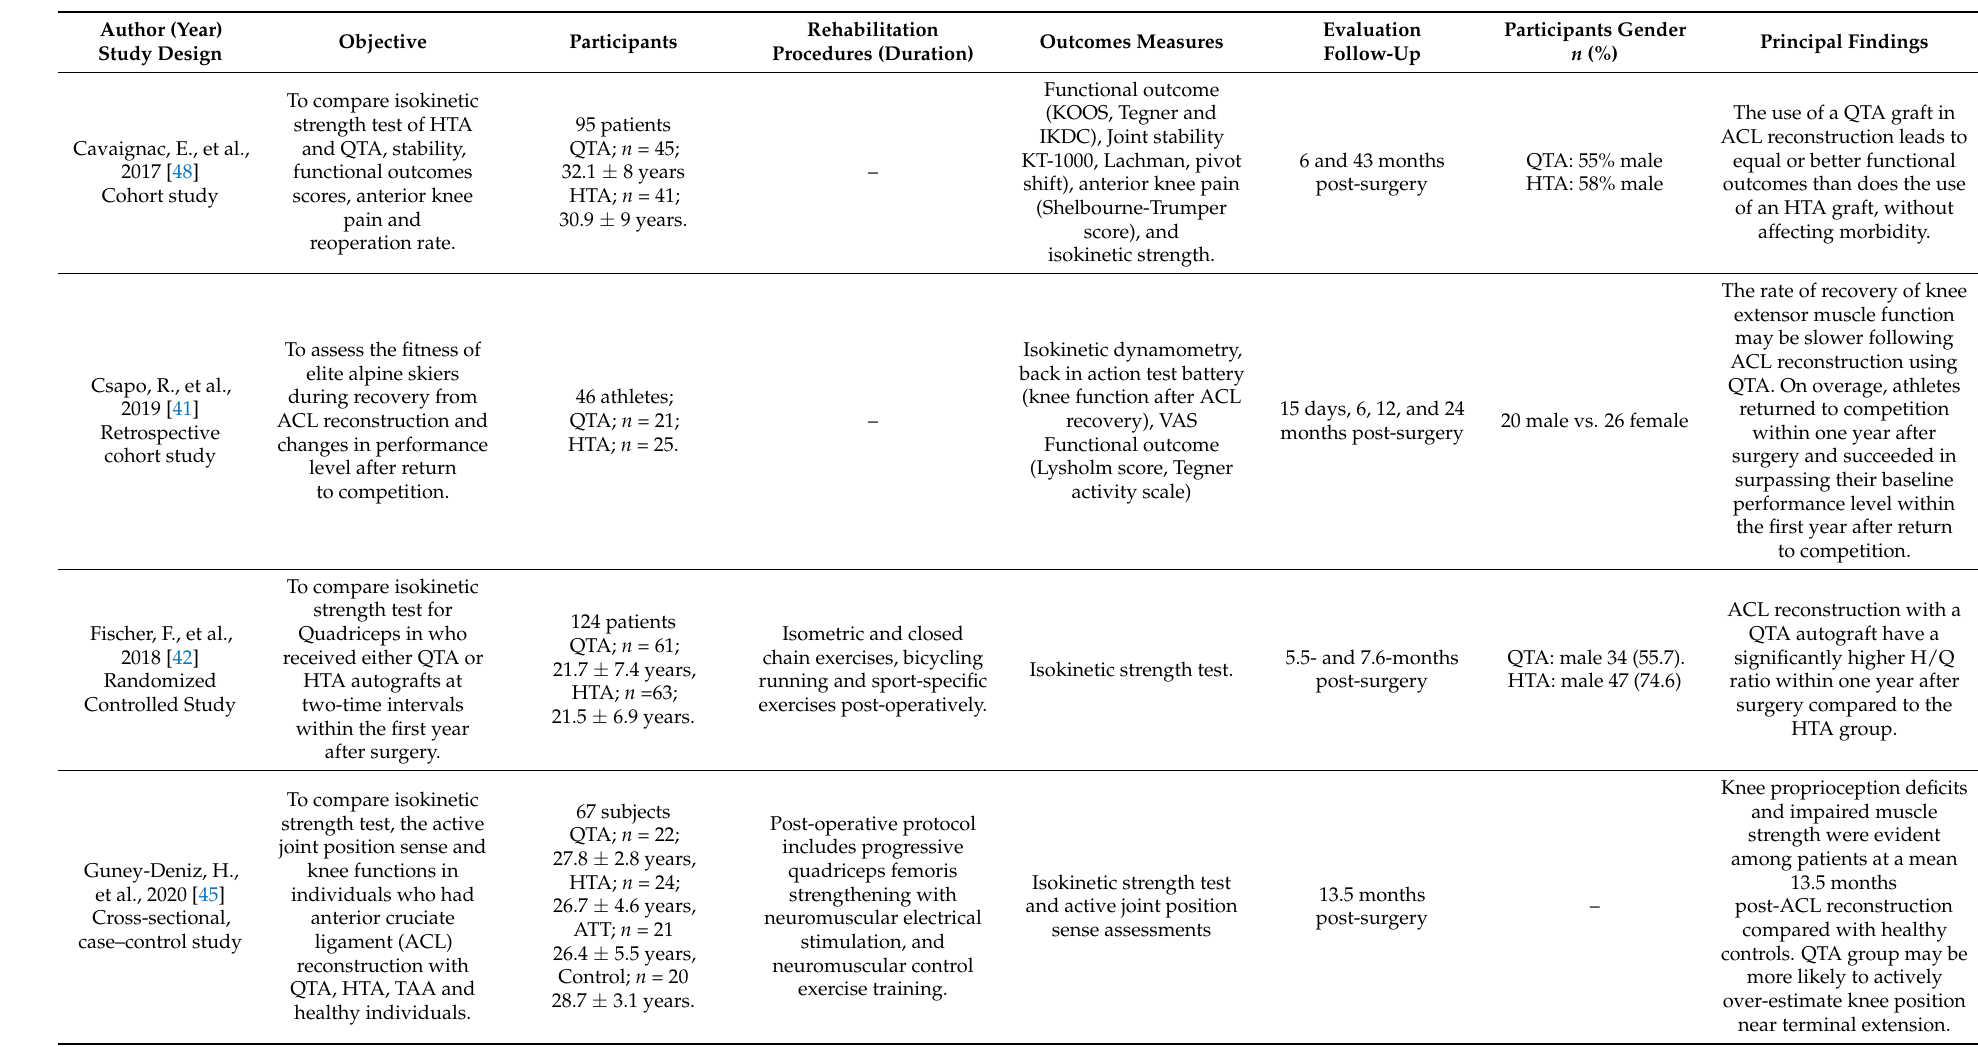
Table 1. Characteristics of 10 studies included, according to the methodology